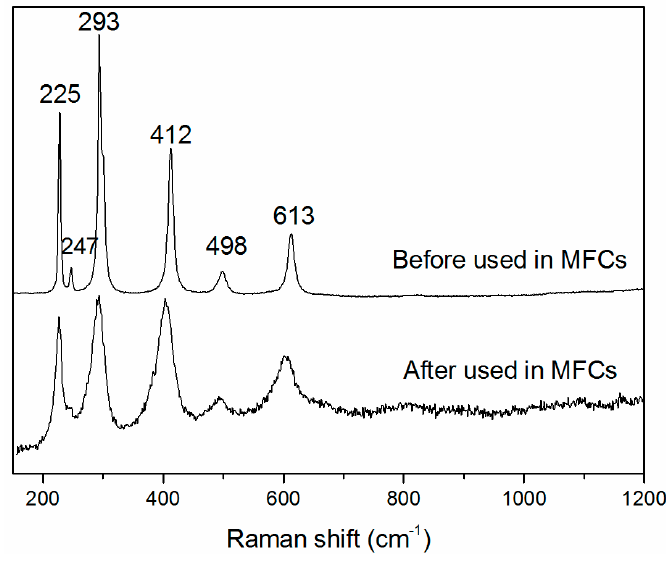
Figure 2. Raman spectrum of natural hematite before and after it was used in MFCs.